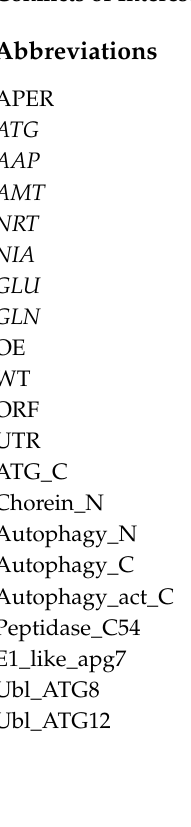
Table S1. The sequence characteristics of CsATG genes in tea plant. Table S2. Molecular evolutionary rate of duplicated CsATG pairs in tea plant. Table S3. ATG domains for AtATGs in Arabidopsis thaliana. Table S4. List of genes and protein sequences used in this study. Table S5. Primer sequences used in this study. Figure S1. Amino acid sequence alignment of CsATG8e and ATG8 members in Arabidopsis and tea plant. Figure S2. The concentration of N, P and K in overexpression Arabidopsis (OE) and wild type (WT) under three N regimes. Figure S3. Analysis of P and K content and allocation in overexpression Arabidopsis (OE) and wild type